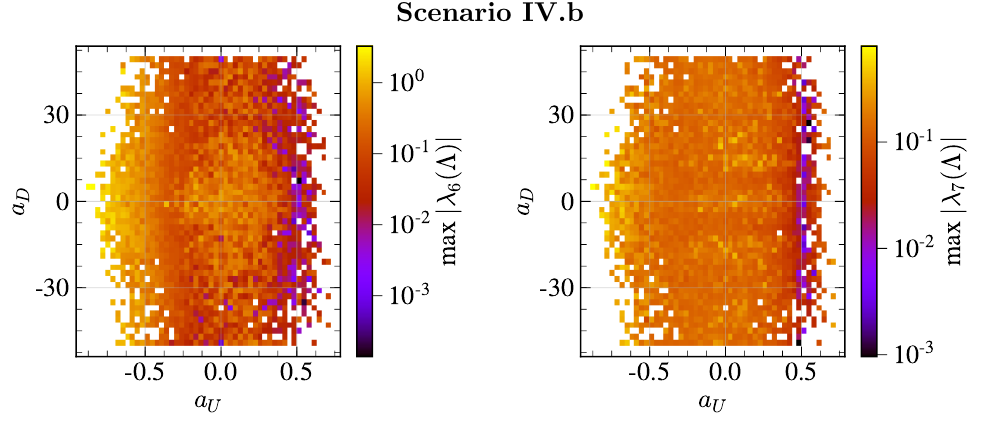
Figure 13 . Generated (cid:21) 6 (Left) and (cid:21) 7 (Right) at the scale (cid:3) = 10 10 GeV as a function of the alignment parameters a U and a D